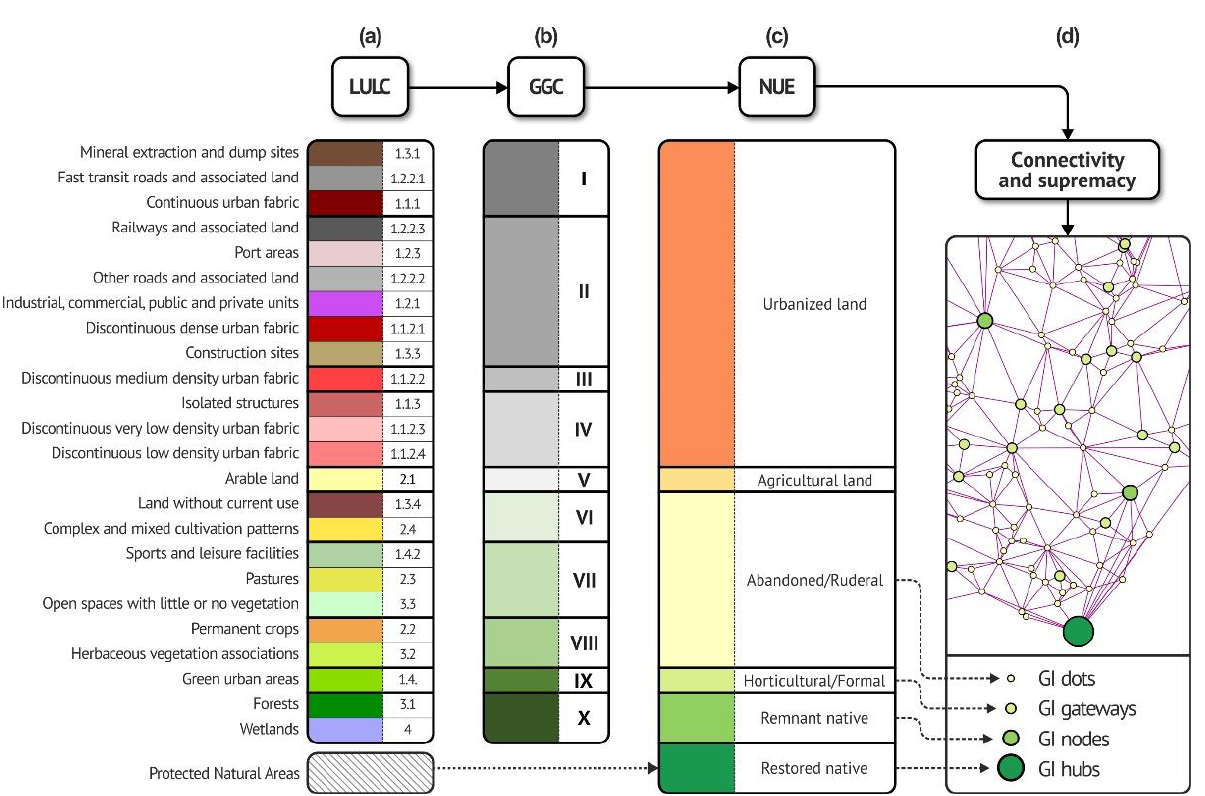
Figure 2. Methodological framework: а schematic outline of the phases – (a) present state of land use/land cover classes, (b) grey-green continuum principle, (c) novel urban ecosystems/landscapes typology and (d) spatial analysis of GI elements.